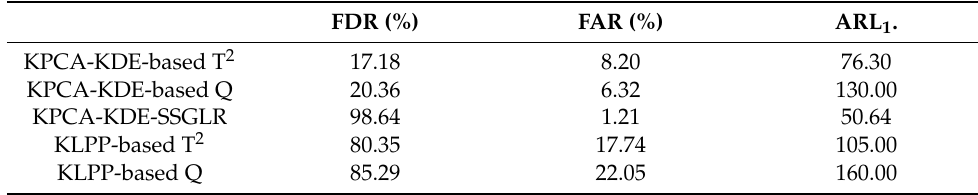
Table 5. False detection/alarm rate and ARL 1 of KPCA-KDE-SSGLR and KLPP.